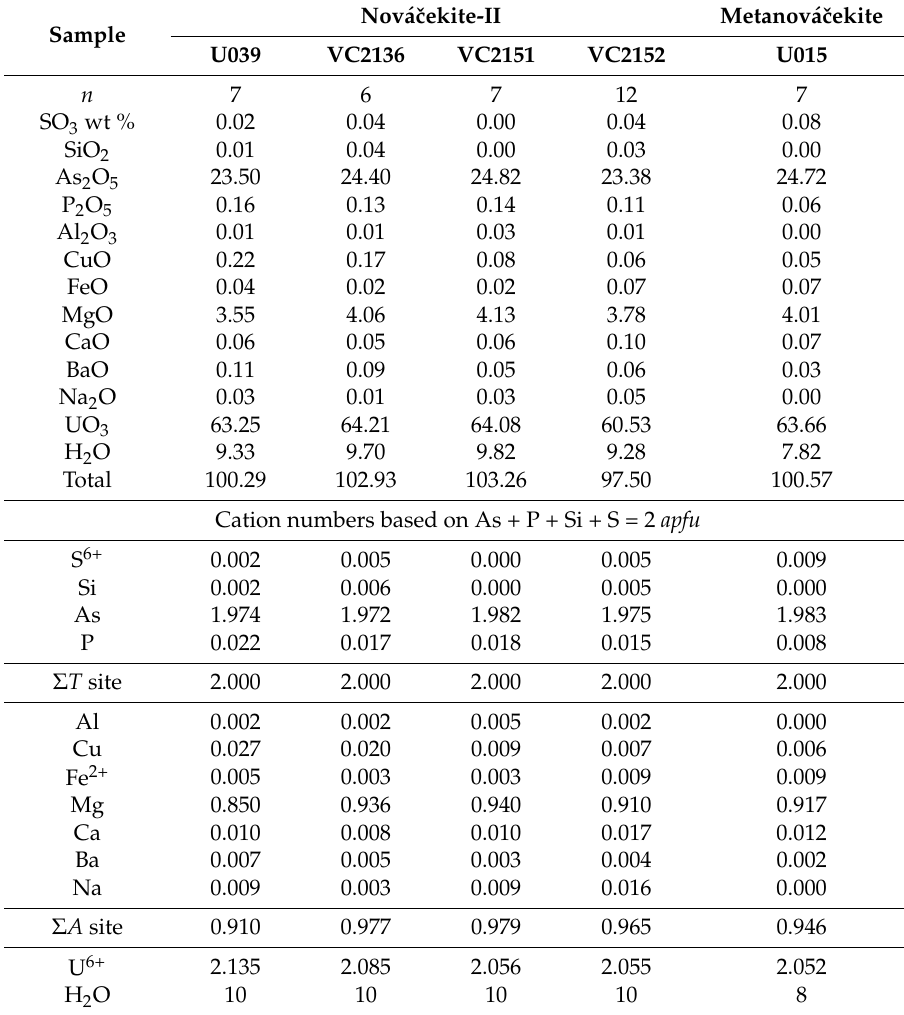
Table 4. Chemical composition of nov á ˇcekite-II and metanov á